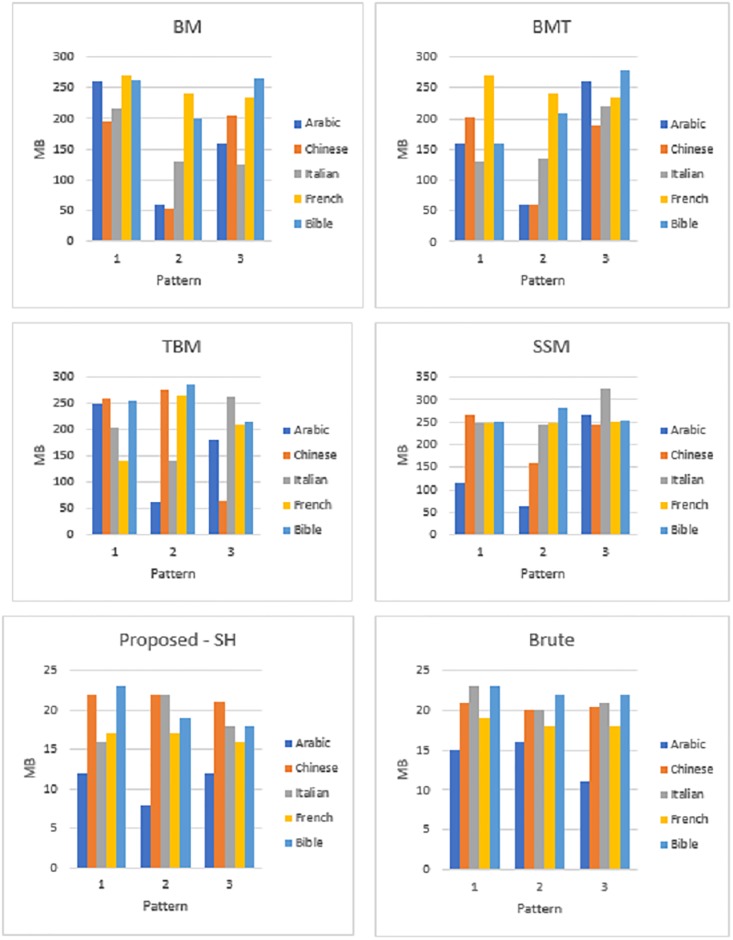
Memory analysis.